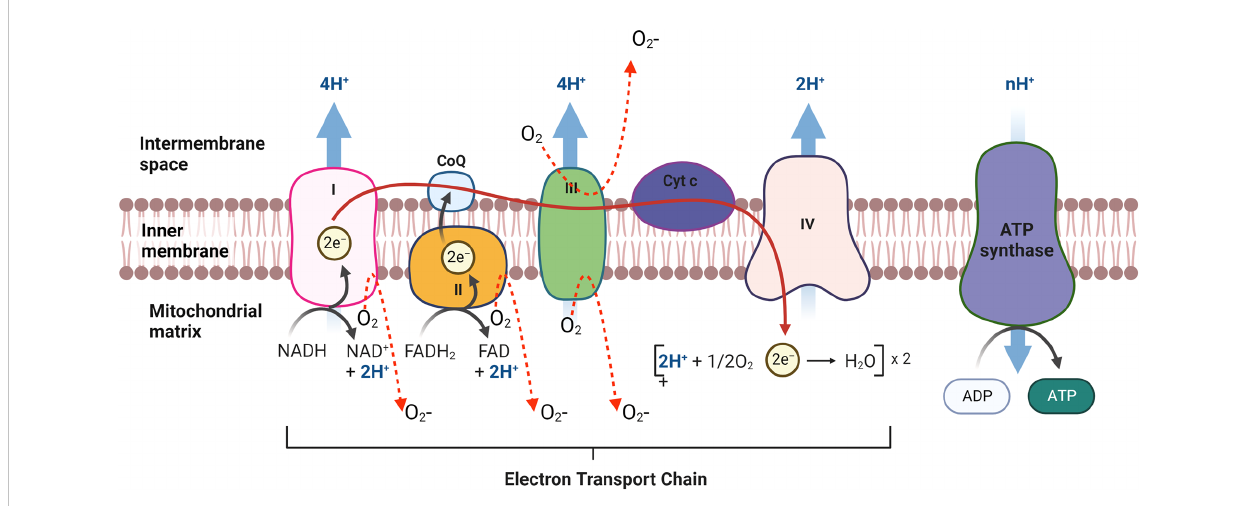
FIGURE 4 mtROS production in Electron transport chain (ETC) in mitochondria. The ETC is located in the mitochondrial inner membrane (IM). Complex I and II supply electrons to coenzyme Q (CoQ; ubiquinone). Sequentially, electrons are transferred from CoQ to Complex III, cytochrome c (Cyt c) and Complex IV. Oxidative stress is generated during electron